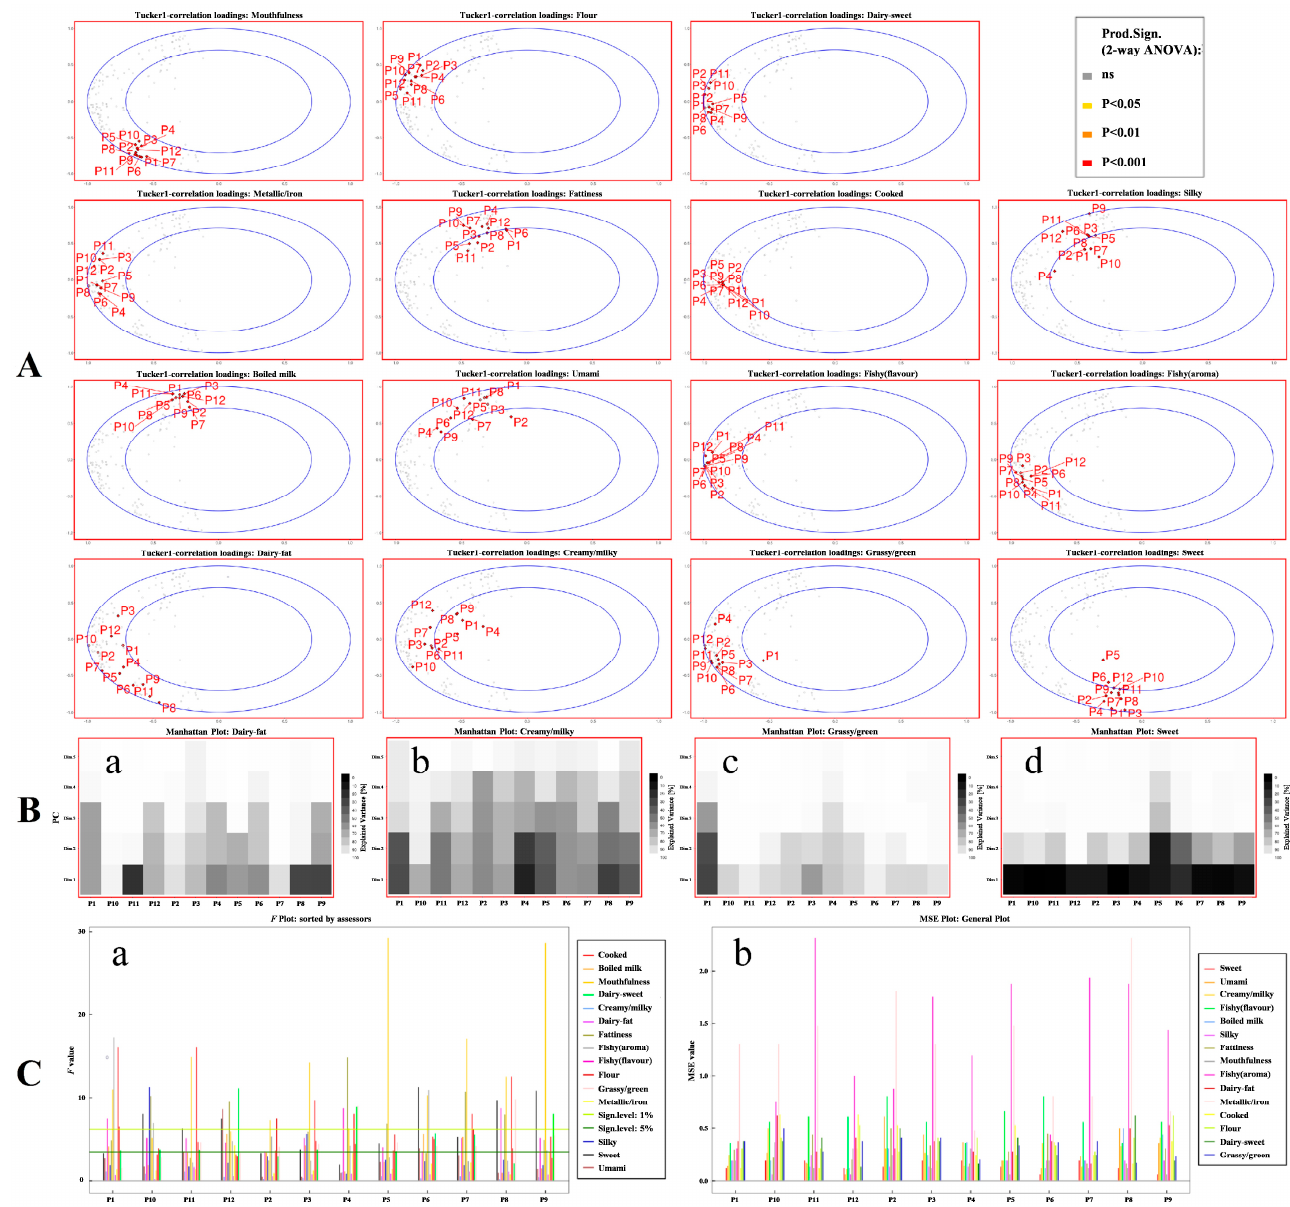
Figure 3. Evaluation of the sensory panel performance. ( A , B ) consistency, ( C ( a )) discrimination ability, ( C ( b )) repeatability. (p: panelists). ( B ( a – d )) Manhattan plot of dairy-fat, creamy, grassy/green and sweet,